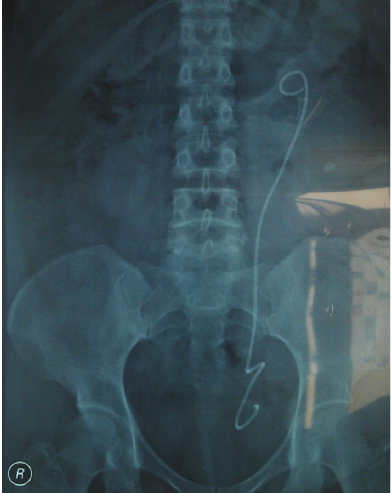
Figure 2: The Omega-like shape of the lower ureter after double J cathether insertion.